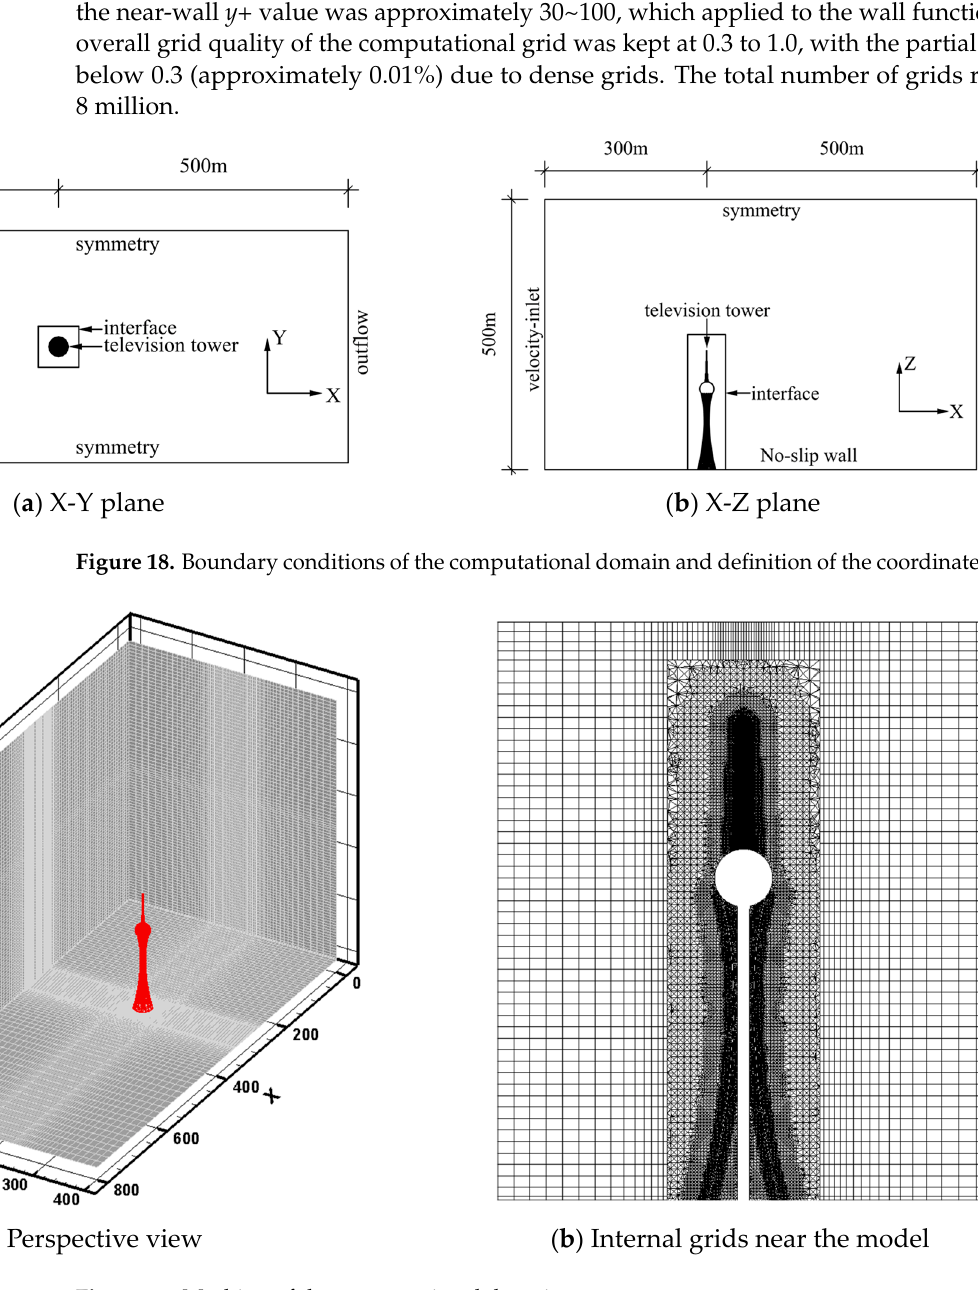
Figure 19. Meshing of the computational domain.